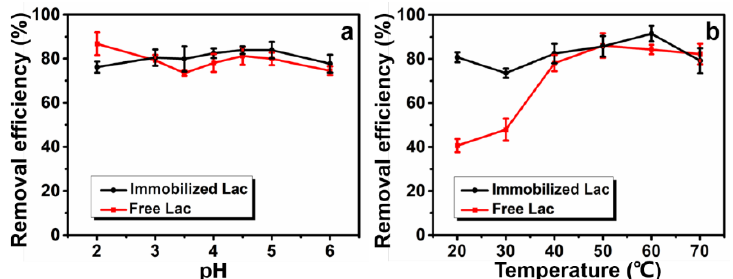
Figure 8. Effect of pH value ( a ) and temperature ( b ) on CV (50 mg/L) removal efficiency. Figure 8. E ff ect of pH value ( a ) and temperature ( b ) on CV (50 mg / L) removal e ffi